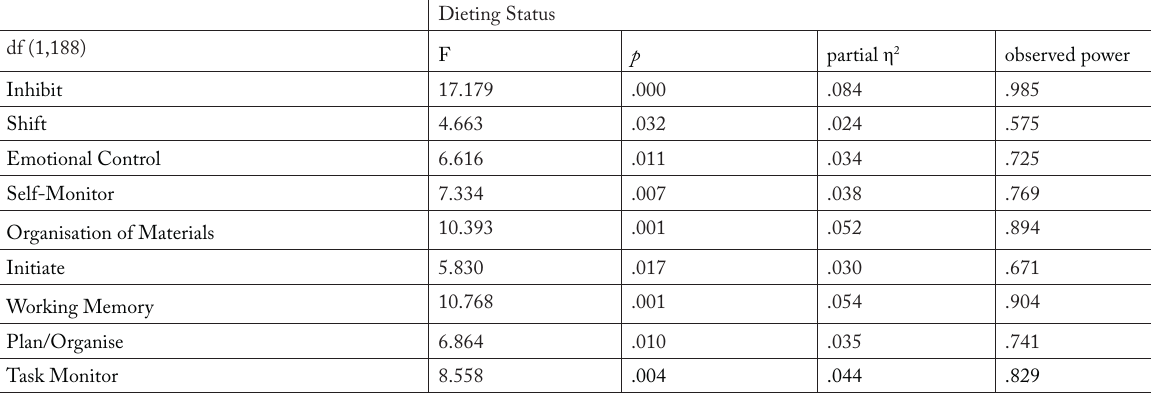
Table 3. MANOVA results for Dieters and Non-Dieters, for the nine BRIEF-A sub-scales. Dieting Status